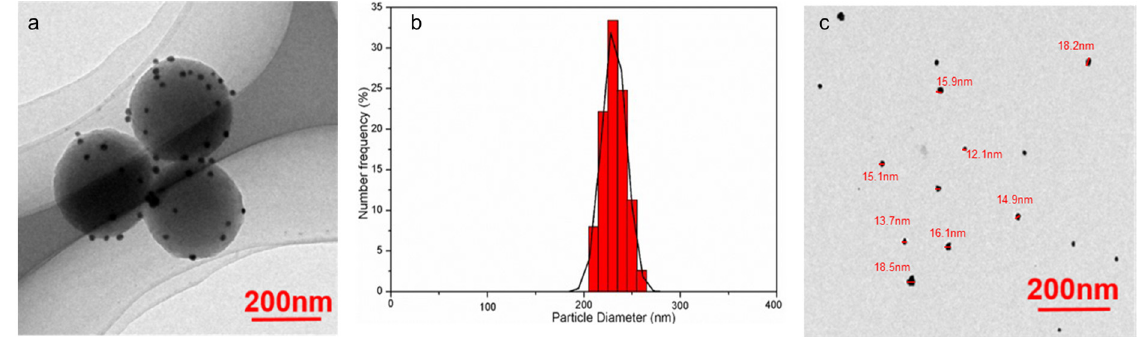
Figure 1. TEM images ( a ) and DLS curve ( b ) of the polydopamine sphere embellished with silver nanoparticles (Ag@PDS), and TEM images ( c ) of AgNPs.